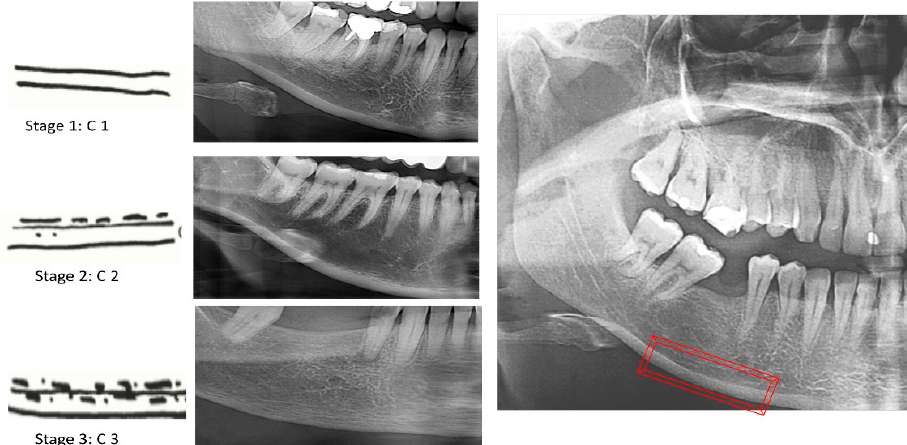
Figure 2. Classification of the MCI index (The area of evaluation in